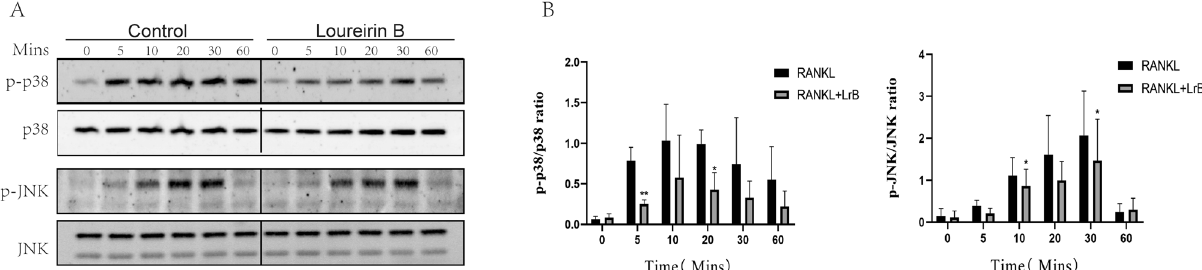
Figure 7. LrB inhibits MAPK and NFATc1 signaling pathways. LrB was used to pretreat the BMMs for 1 h followed by 0, 5, 10, 20, 30 and 60 min. Total cellular proteins were extracted using RIPA lysis buffer and cell lysates were analyzed by Western blotting using primary antibodies specific to p-p38, p38, p-JNK and JNK. The ratios of p-p38/p38 and p-JNK/JNK show the inhibitory effect of LrB on MAPK pathway signaling specific to p-p38 and p-JNK (n =